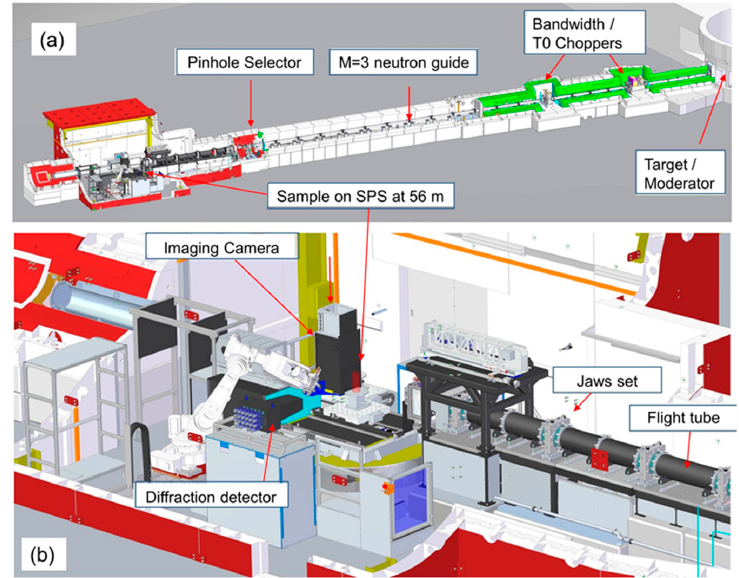
Figure 2. IMAT instrument layout. ( a ) The length of the instrument from source to sample position is 56 m. ( b ) The main components in the sample area are: evacuated flight tubes; beam limiting jaws; sample positioning system (SPS); imaging camera; diffraction prototype detector.